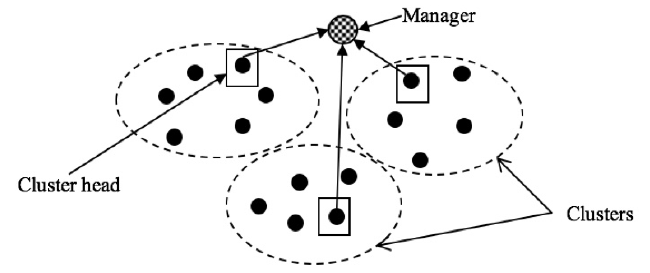
Figure 1. Clusters in traditional mobile network